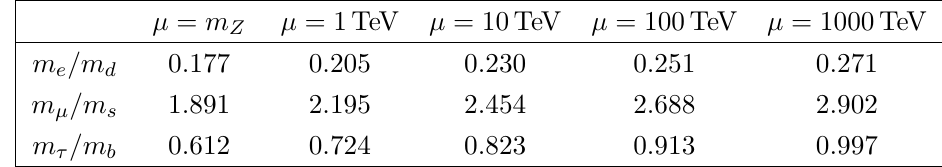
Table 6 . Measured mass ratios m e /m d for each generation at fixed energy scales µ at one-loop and assuming SM running of the Yukawas. Additional details of the running calculations performed can be found in appendix